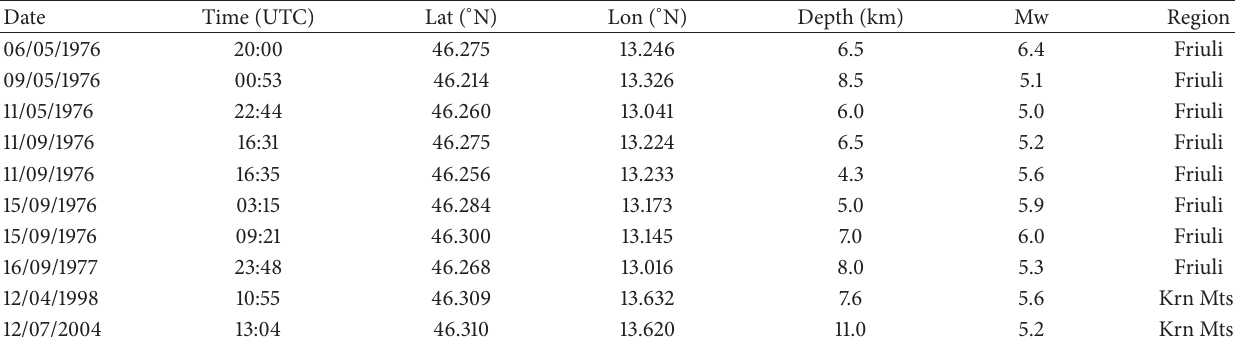
Table 1: Data for earthquakes with Mw ≥ 5.0 in the vicinity of Breginski kot (after [4, 7, 8]).